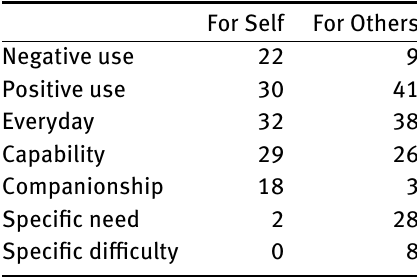
Table 8: Responses by Category to open-ended items.